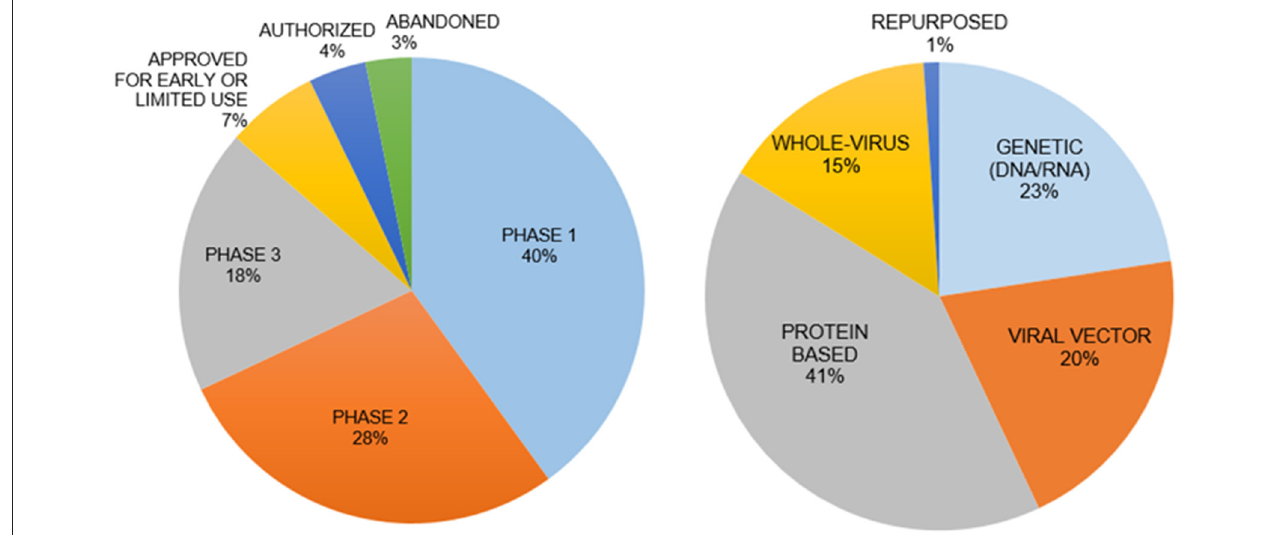
FIGURE 3 | Vaccine types and clinical phases of their development. The genetic vaccines immunize with mRNA for SARS-CoV-2 and protein-based vaccines immunize with spike protein to induce immunity. The interim analysis of phase 3 clinical trials for both types of vaccines have been disclosed with promising results in November 2020. The mRNA vaccines are a new principle with little information on how long the induced immunity will